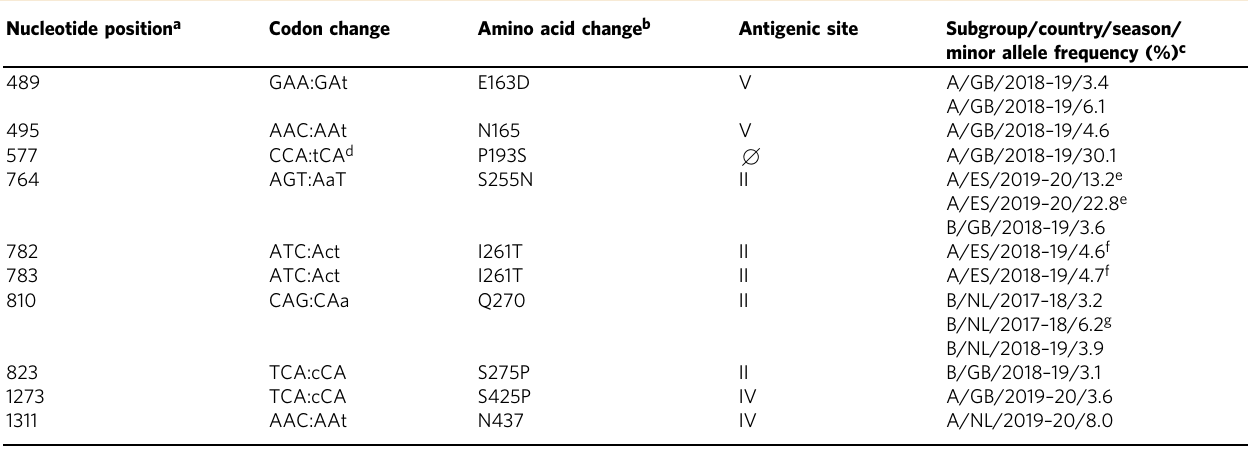
Fig. 1 Minor variants in the coding region of the F and G genes among 175 RSV-A and 144 RSV-B samples. a F gene. Shaded regions represent known antigenic sites (neutralising epitopes in particular): red, prefusion-speci fi c antigenic site + (target for nirsevimab); green, site II (target for palivizumab and motavizumab); yellow, site IV (target for 101F) and blue, prefusion-speci fi c site V (target for suptavumab). b G gene. The purple region represents the conserved central domain (target for 3D3 and 2D10), fl anked by highly variable mucin-like regions I (grey) and II (orange). Nirsevimab, palivizumab, motavizumab, 101F, suptavumab, 3D3 and 2D10 are RSV-speci fi c monoclonal antibodies. Each dot denotes a minor variant, coloured by subgroup. Black dashed line represents minor allele frequency of 3%, used to de fi ne a minor variant. Positions are numbered from the fi rst base of the coding sequence of each gene according to the NCBI reference sequence (accession number NC_038235). Table 2 Characteristics of minor variants within the antigenic sites of the fusion